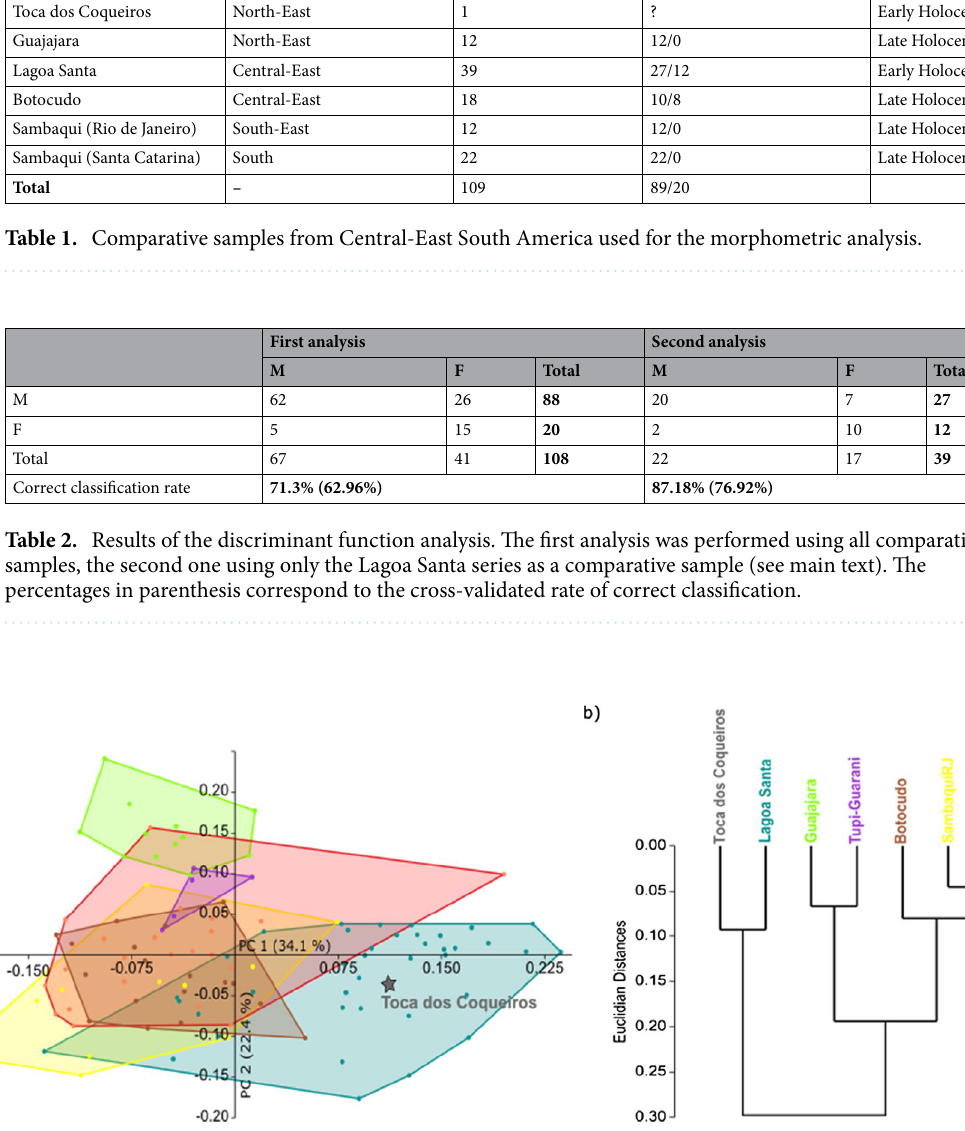
Figure 3. Morphometric results: ( a ) PCA showing the distribution of samples along the PC1 (Principal Component 1) and PC2 (Principal Component 2) of the cranial shape variables. Convex hulls indicate populations. Late Holocene samples: Guajajara (green), Sambaqui SC (red), Sambaqui RJ (yellow), Tupi-Guarani (purple), Botocudo (brown); early Holocene samples: Lagoa Santa (turquoise). The individual from Toca dos Coqueiros is highlighted with a star symbol; ( b ) Cladogram showing the results of the Ward’s hierarchical clustering